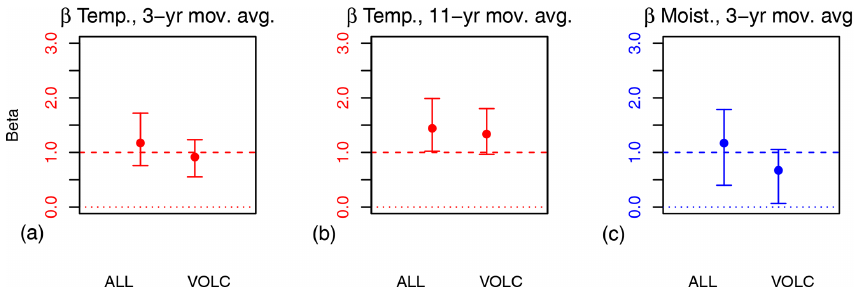
Figure 7. (a) Beta values and uncertainties for 3-year moving averages (following DelSole et al., 2019) in the TLS D&A analysis for temperature-sensitive TRW (Fig. 2a, b). ALL and VOLC indicate regression on the all-forcing- and volcanic-forcing-based TRW simulations, respectively. Panel (b) is the same as panel (a) but for 11-year running means; uncertainties are adjusted for serial autocorrelation. Panel (c) is the same as panel (a) but for moisture-sensitive TRW (Fig. 2c, d) with the aggregate mean response grouped by the two regions based on the positive or negative response of the TRW simulations (Fig. 6f). Uncertainty ranges are based on 90% confidence intervals of scaling